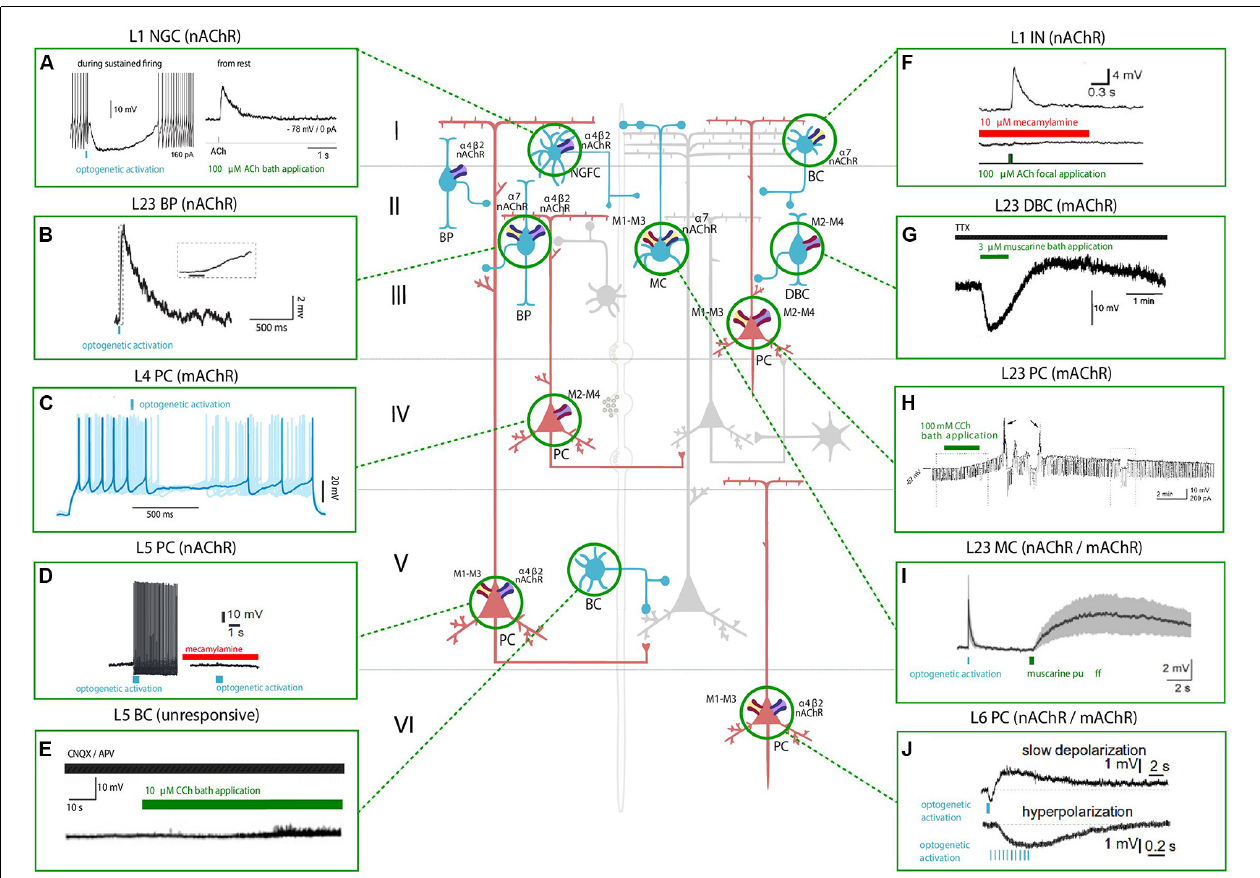
FIGURE 1 | Effect of nicotinic acetylcholine receptors (nAChRs) and muscarinic ACh receptors (mAChRs) activation on the membrane potential of various neocortical cell types. The central schema represents the main cell types in the neocortex. Excitatory neurons are shown in red and inhibitory GABAergic neurons are shown in blue. The electrophysiological responses to the optogenetic activation of cholinergic fibers (in light blue) or the application of a cholinergic agonist (shown in green) or antagonist (shown in red) of each cell type are depicted in the inserts. Timing of cholinergic manipulation is shown as a vertical or horizontal bar. Muscarinic and nicotinic cholinergic receptors associated with the observed response, when known, are shown as four main subtypes: M1-M3-M5 like receptors (yellow and red), M2-M4 like receptors (violet and red), α 4 β 2 heteromeric nAChRs (violet and blue) and α 7 homomeric nAChRs (yellow and blue). All shown experimental traces reflect studies listed in Tables 1 , 2 . Selected traces were recorded in sensory areas of the rodent neocortex. Inclusion criteria for the experimental traces comprise knowledge of the cell-types and the receptor subtype (nicotinic or muscarinic) involved in the electrophysiological response. Abbreviations: PC, pyramidal cell; SS, spiny-stellate cell; IN, interneuron; MC, Martinotti cell; BC, basket cell; DBC, double-bouquet cell; NGFC, neurogliaform cell; BPC, bipolar cell. Reproduced and adapted from: (left, top to bottom): (A) . Brombas et al., 2014; (B) Arroyo et al., 2012; (C) Dasgupta et al., 2018; (D) Hedrick and Waters, 2015; (E) Kawaguchi, 1997 (Right, top to bottom): (F) Gulledge et al., 2007; (G) Kawaguchi, 1997; (H) Shalinsky et al., 2002; (I) Dasgupta et al., 2018; (J) Hedrick and Waters, 2015. For more exhaustive information on agonist concentration, species and cortical area examined, see Tables 1 , 2 .